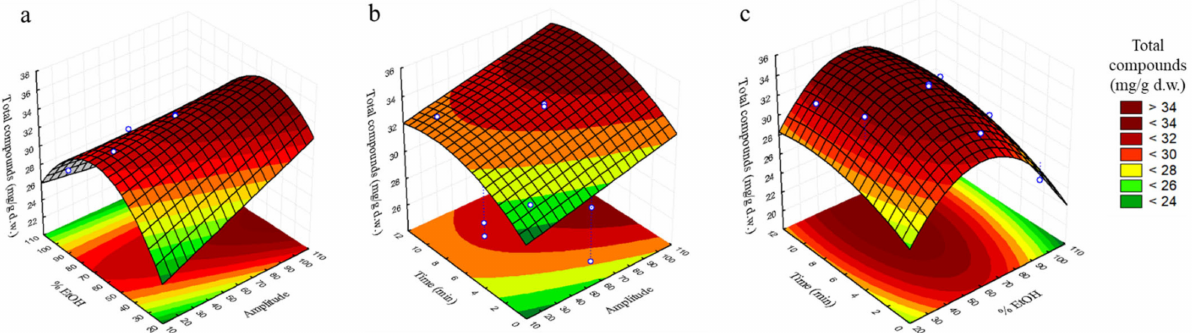
Figure 2. Response surface plots showing combined effects of process variables for total compounds (mg/g d.w.): amplitude—% EtOH ( a ), amplitude—time (min) ( b ) and % EtOH—time (min) ( c